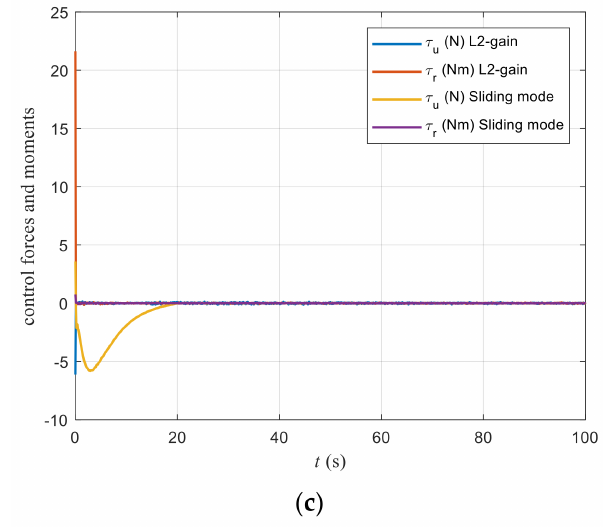
Figure 10. Course-keeping control of the training ship Blue Lady. ( a ) Disturbances at the level of 0.05*randn ( b ) variation in heading angle and yaw rate ( c ) control forces and